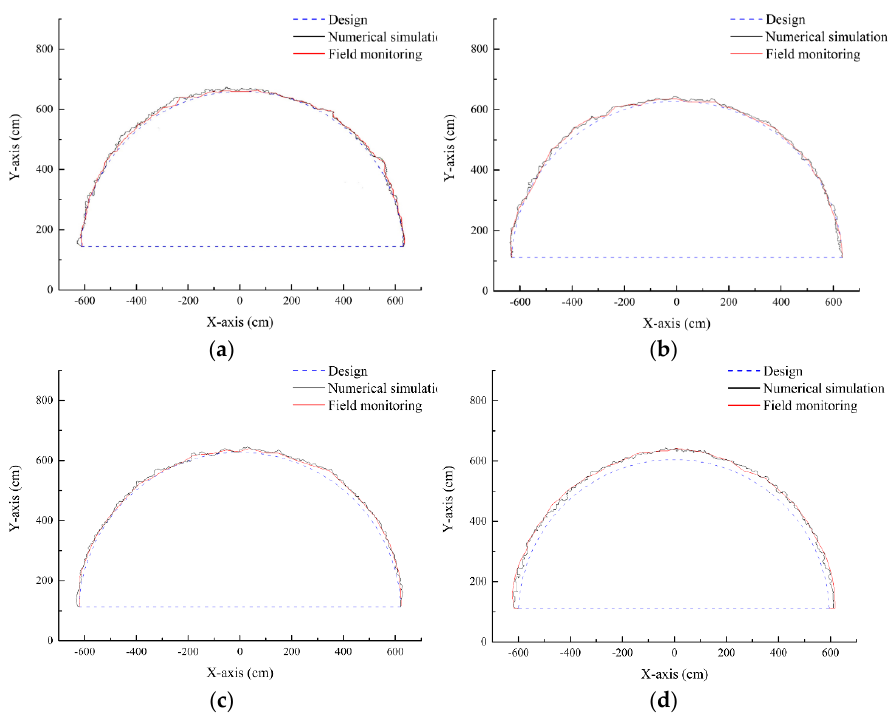
Figure 10. Comparison of section contour between numerical simulation and field monitoring: ( a ) massive integrity structure; ( b ) massive structure; ( c ) layered structure; and ( d ) cataclastic structure.